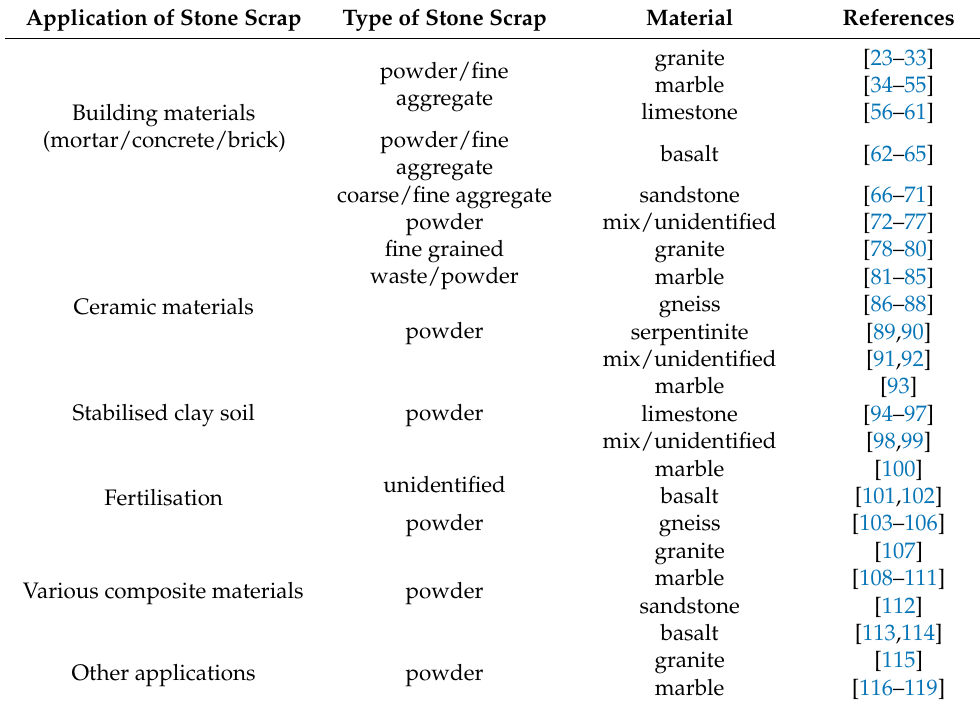
Table 4. Literature research on the possibilities of application of stone